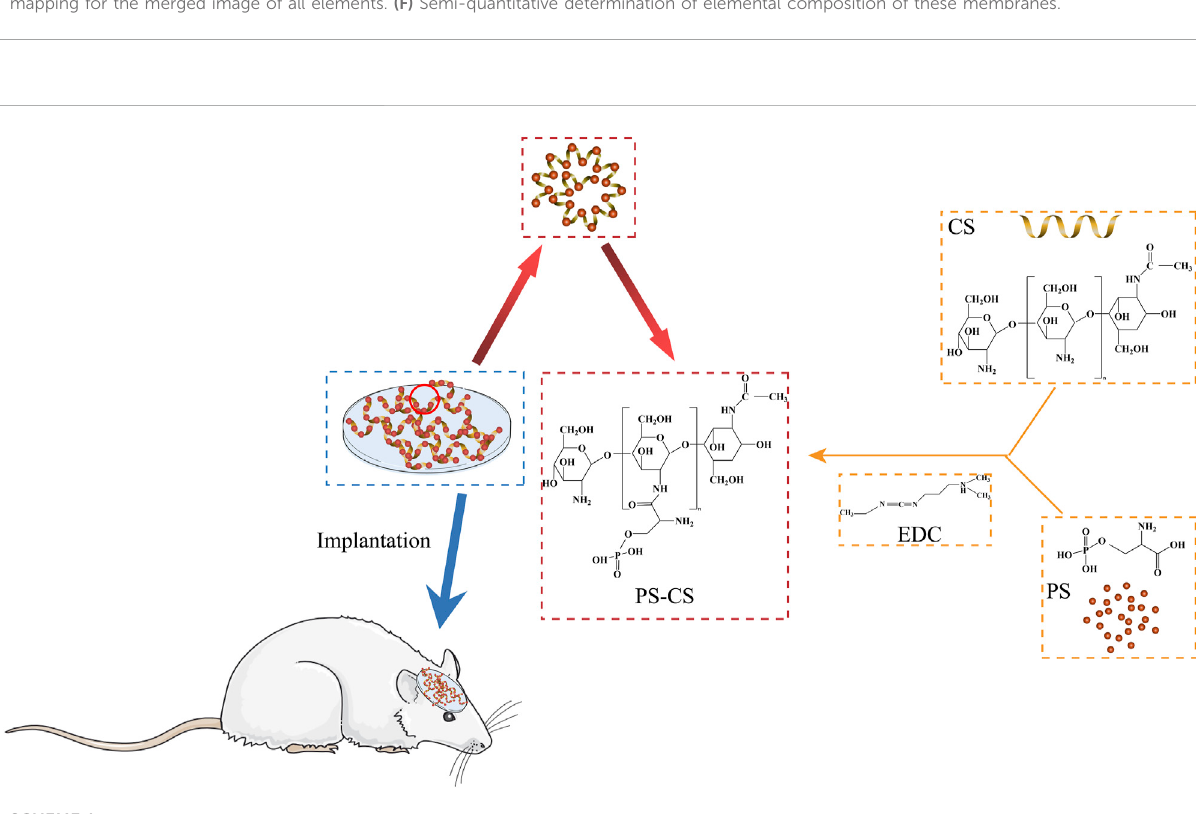
SCHEME 1 Schematic illustration for fabrication of phosphoserine-chitosan